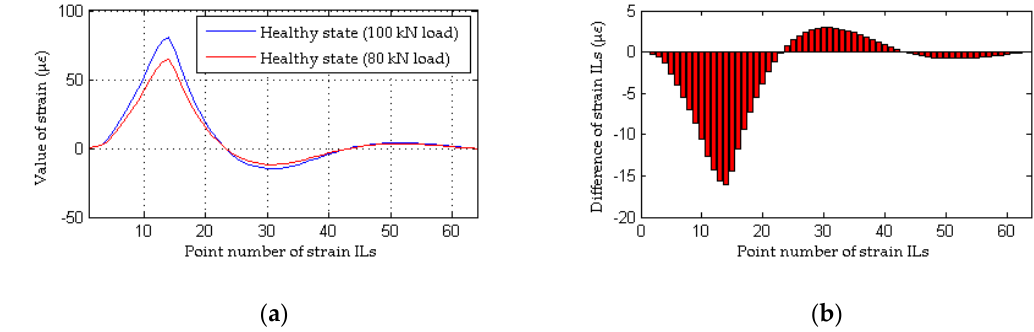
Figure 12. Results of the traditional method considering the effects of loading conditions: (a) strain ILs at point #11 between case 1 and case 8; (b) difference in the strain ILs at point #11 before and after damage for case 8.